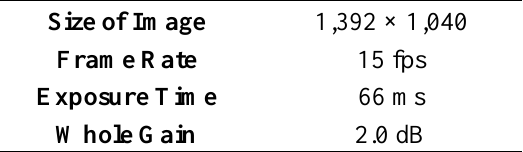
Table 1. Specifications of Lumenera Lu 135